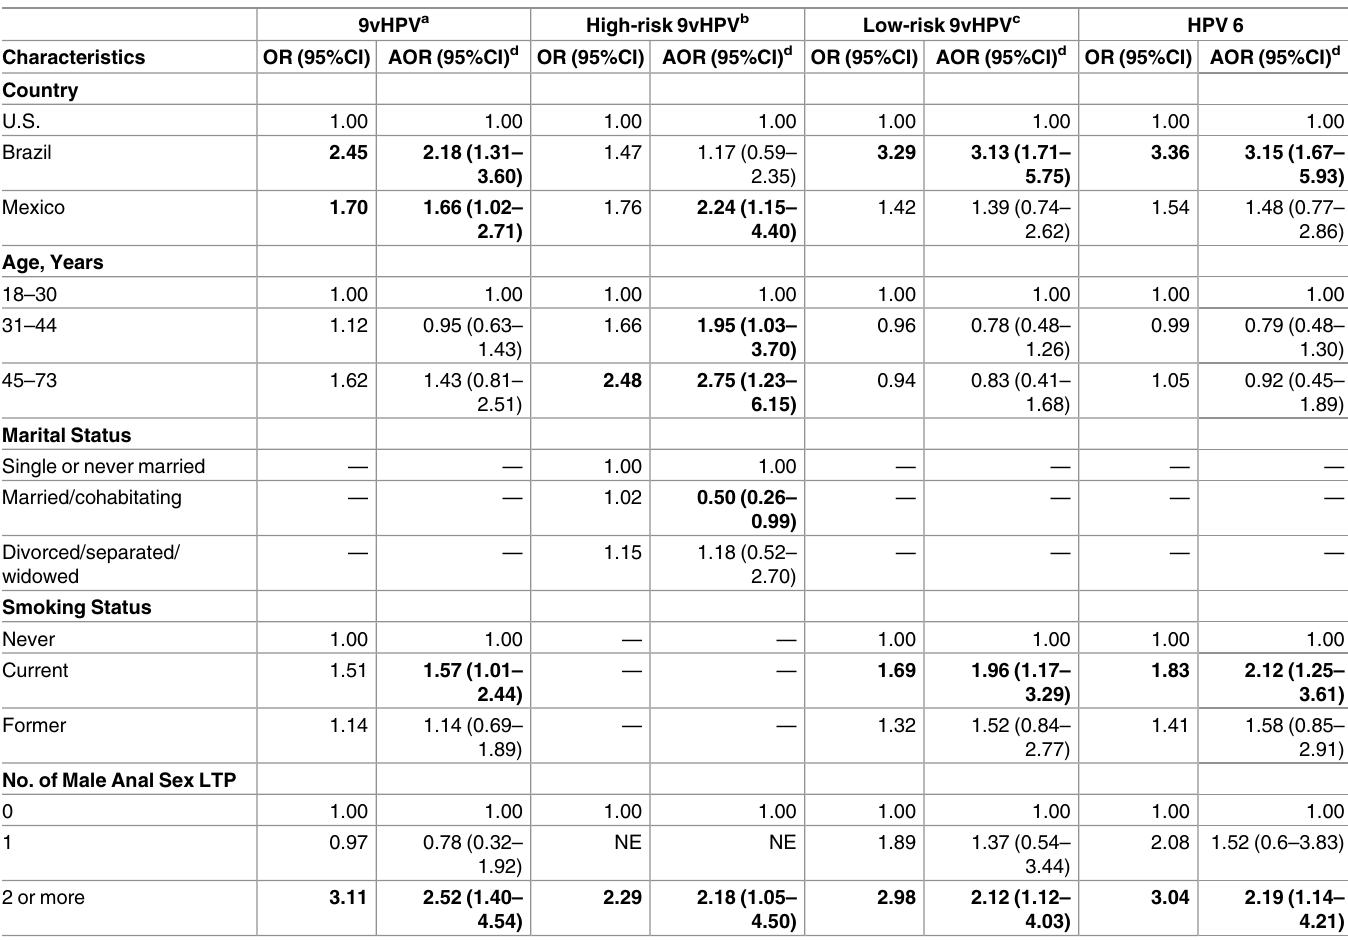
Table 3. Factors independently associated with seropositivity of nine vaccine type HPV in men from Brazil, Mexico and the United